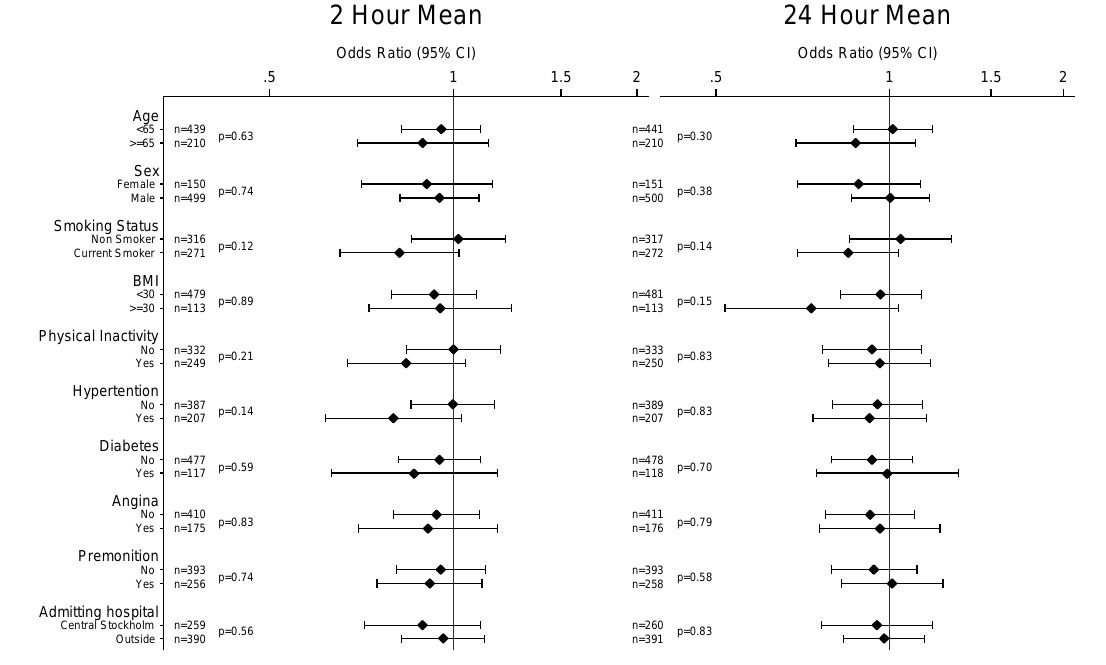
Figure 3. Odds ratios of myocardial infarction for an interquartile range increase in 2 h and 24 h moving averages of CO in different subgroups (P-values for interaction). Number of observations for each subgroup with complete data on analyzed covariate and air pollution indicated by